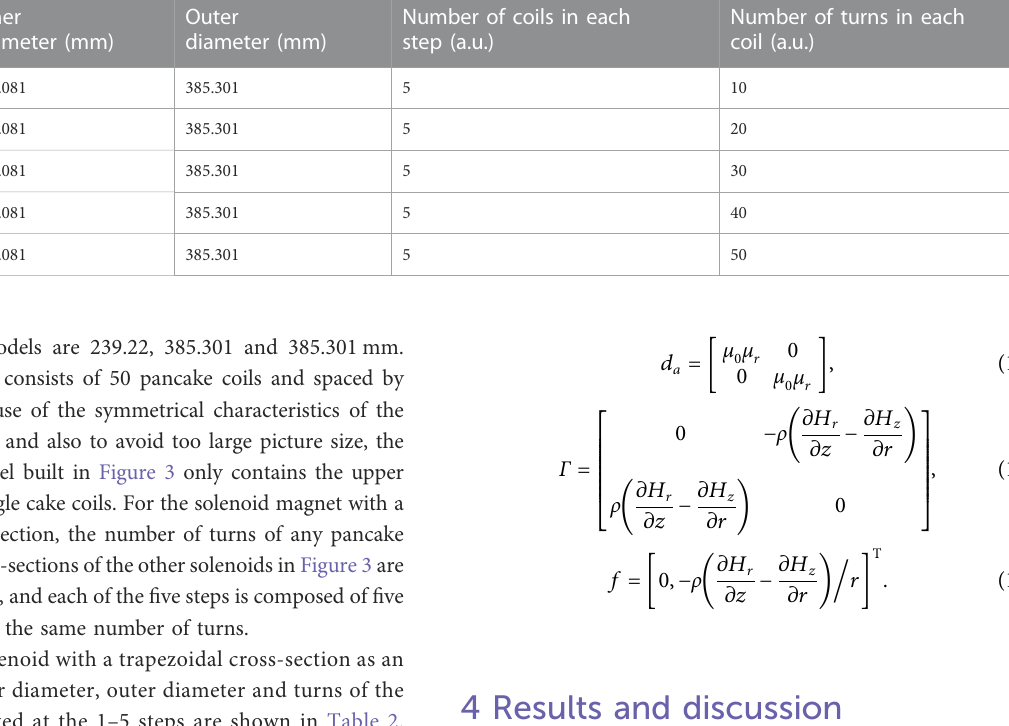
Number of turns in each coil (a.u.)